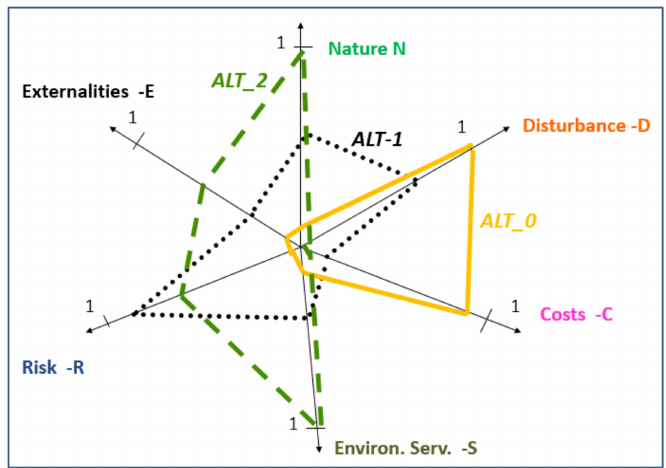
Figure 11. In the hypothetical example, the ALT_0 alternative (“business as usual”) induces the least disturbance because it does not touch the “status quo” and implies the least cost, as it does not require investments; yet it behaves very badly from all other points of view. ALT_2 performs best over the N objective as well as over the other environmental services (S), but is the worst in terms of costs. (The “radar” representation adopted here is just one amongst others, e.g., histogram, tables, etc., and is not always the best; it requires a normalization of the objective and a positive orientation of the axis, i.e., “1” is the best, while “0” the worst. What counts is the position on the axis, not the undercut